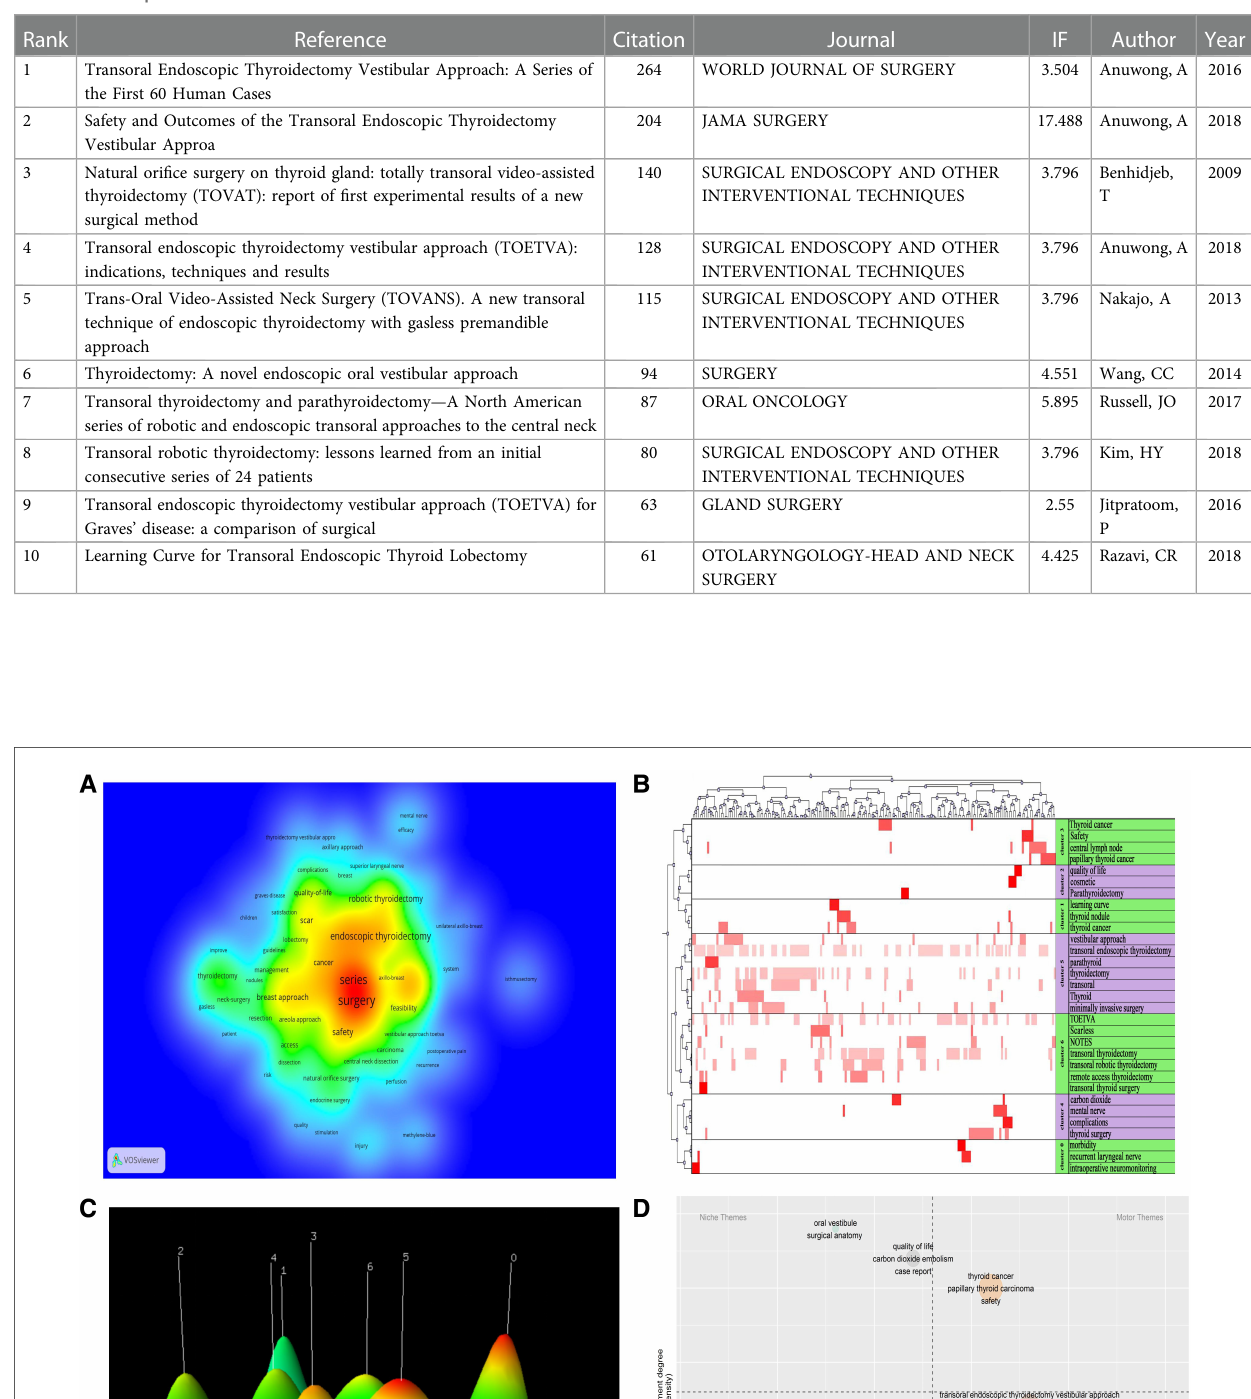
TABLE 2 The top 10 most cited articles in TOETVA fi eld.